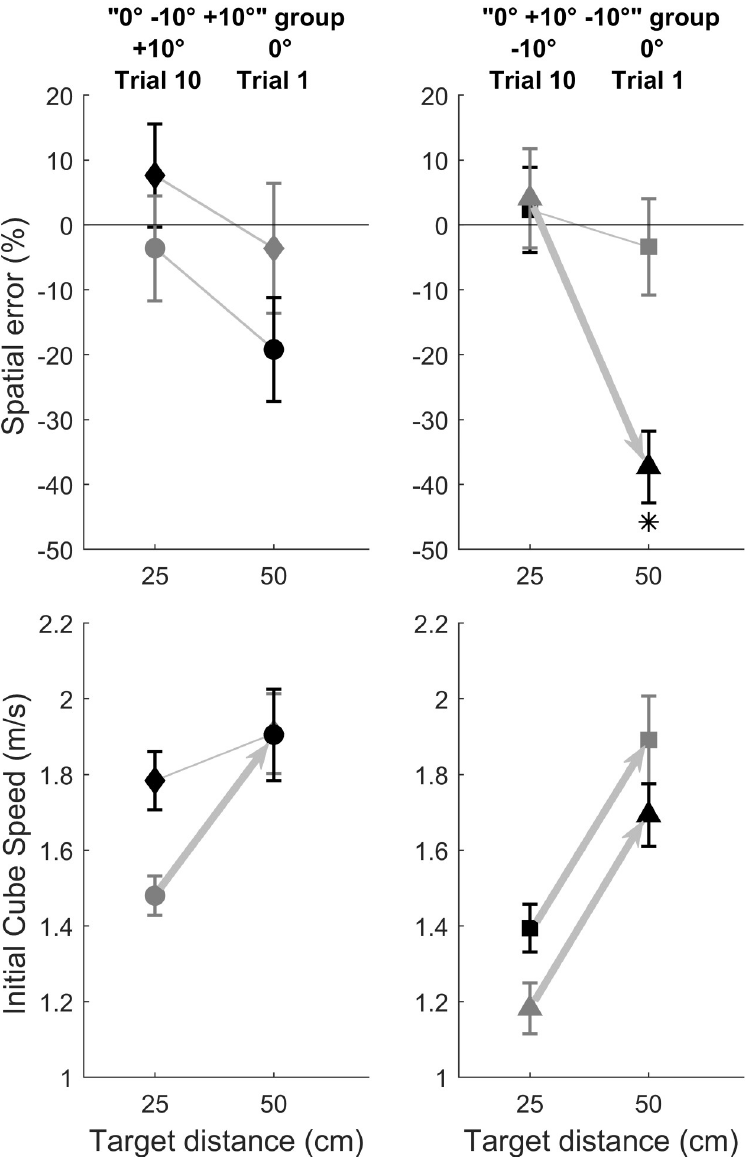
Fig 7. Illustration of performance after a change in three physical properties of the stimulus, i.e., surface slope, surface material and target distance. This change corresponded to the transition between the last trial of block 6 and the first trial of block 7 for the four different groups in this study (see Table 1 for details about block order). Each group is illustrated with a different data point symbol. Gray and black symbols indicate aluminum and balsa wood surface material, respectively. For example, diamonds correspond to a “0˚, -10˚, +10˚” group where the last trial of block 6 was a +10˚ slope with a balsa wood surface material and 25 cm target distance, followed by a 0˚ slope with an aluminum surface material and 50 cm target distance. Asterisks illustrate significant differences in spatial error with respect to zero (Bonferroni correction with α = 0.05/4), and arrows illustrate a significant change in performance between the trials of interest (Bonferroni correction with α = 0.05/4). The results show appropriate movement re-parameterization after a change in three physical properties of the stimulus, except for the more difficult transition indicated by the triangle data points corresponding to a transition from a 25 cm target distance on a -10˚ aluminum surface (optimal initial cube speed is 0.967 m/s, see Table 1) to 50 cm target distance on a 0˚ balsa wood surface (optimal initial cube speed is 2.147 m/s, see Table